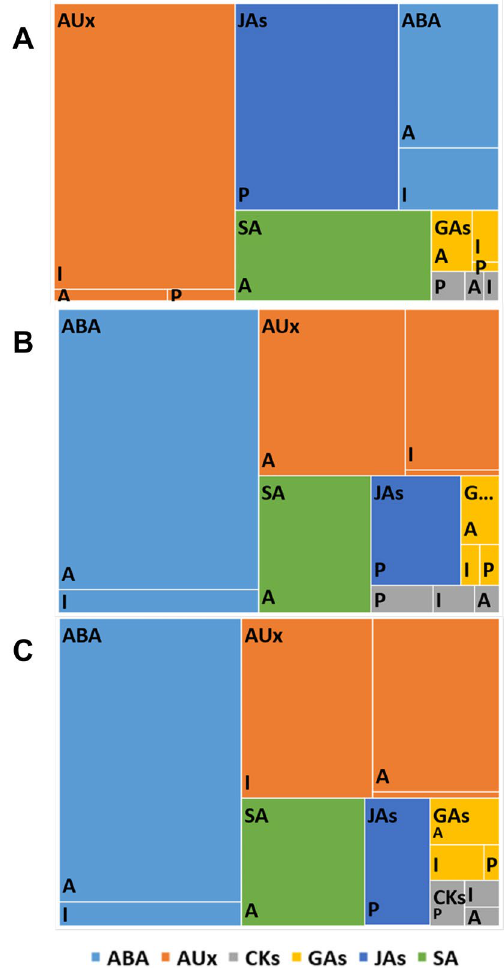
Figure 3. A treemap chart of the hormonal profile of oat cv. ‘Krezus’ embryos. Panel ( A ) haploid embryos, Panel ( B ) zygotic embryos, Panel ( C ) zygotic embryos from ovaries treated with 2,4-D. The total area represents the amount of all measured hormones. Rectangles of different colors: AUx auxins (orange), JAs jasmonates (navy blue), ABA abscisic acid (blue), GAs gibberellins (yellow), SA salicylic acid (green), and CKs cytokinins (grey) represent the share of each compound group divided in to active (A), inactivated (I), and precursor (P)